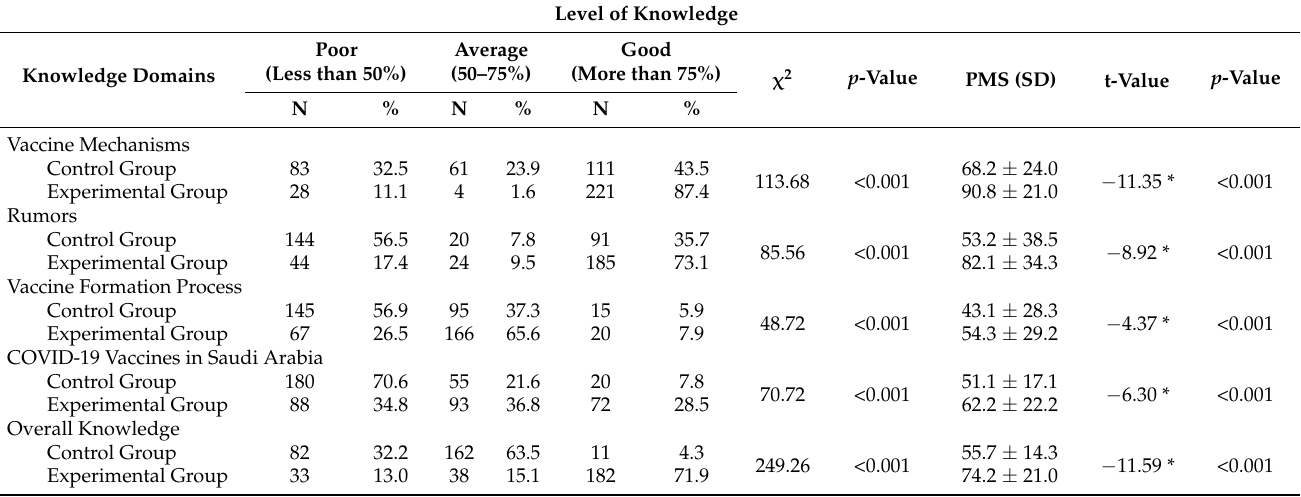
Table 2. Levels of knowledge about the COVID-19 vaccination in different domains of the experi- mental and control